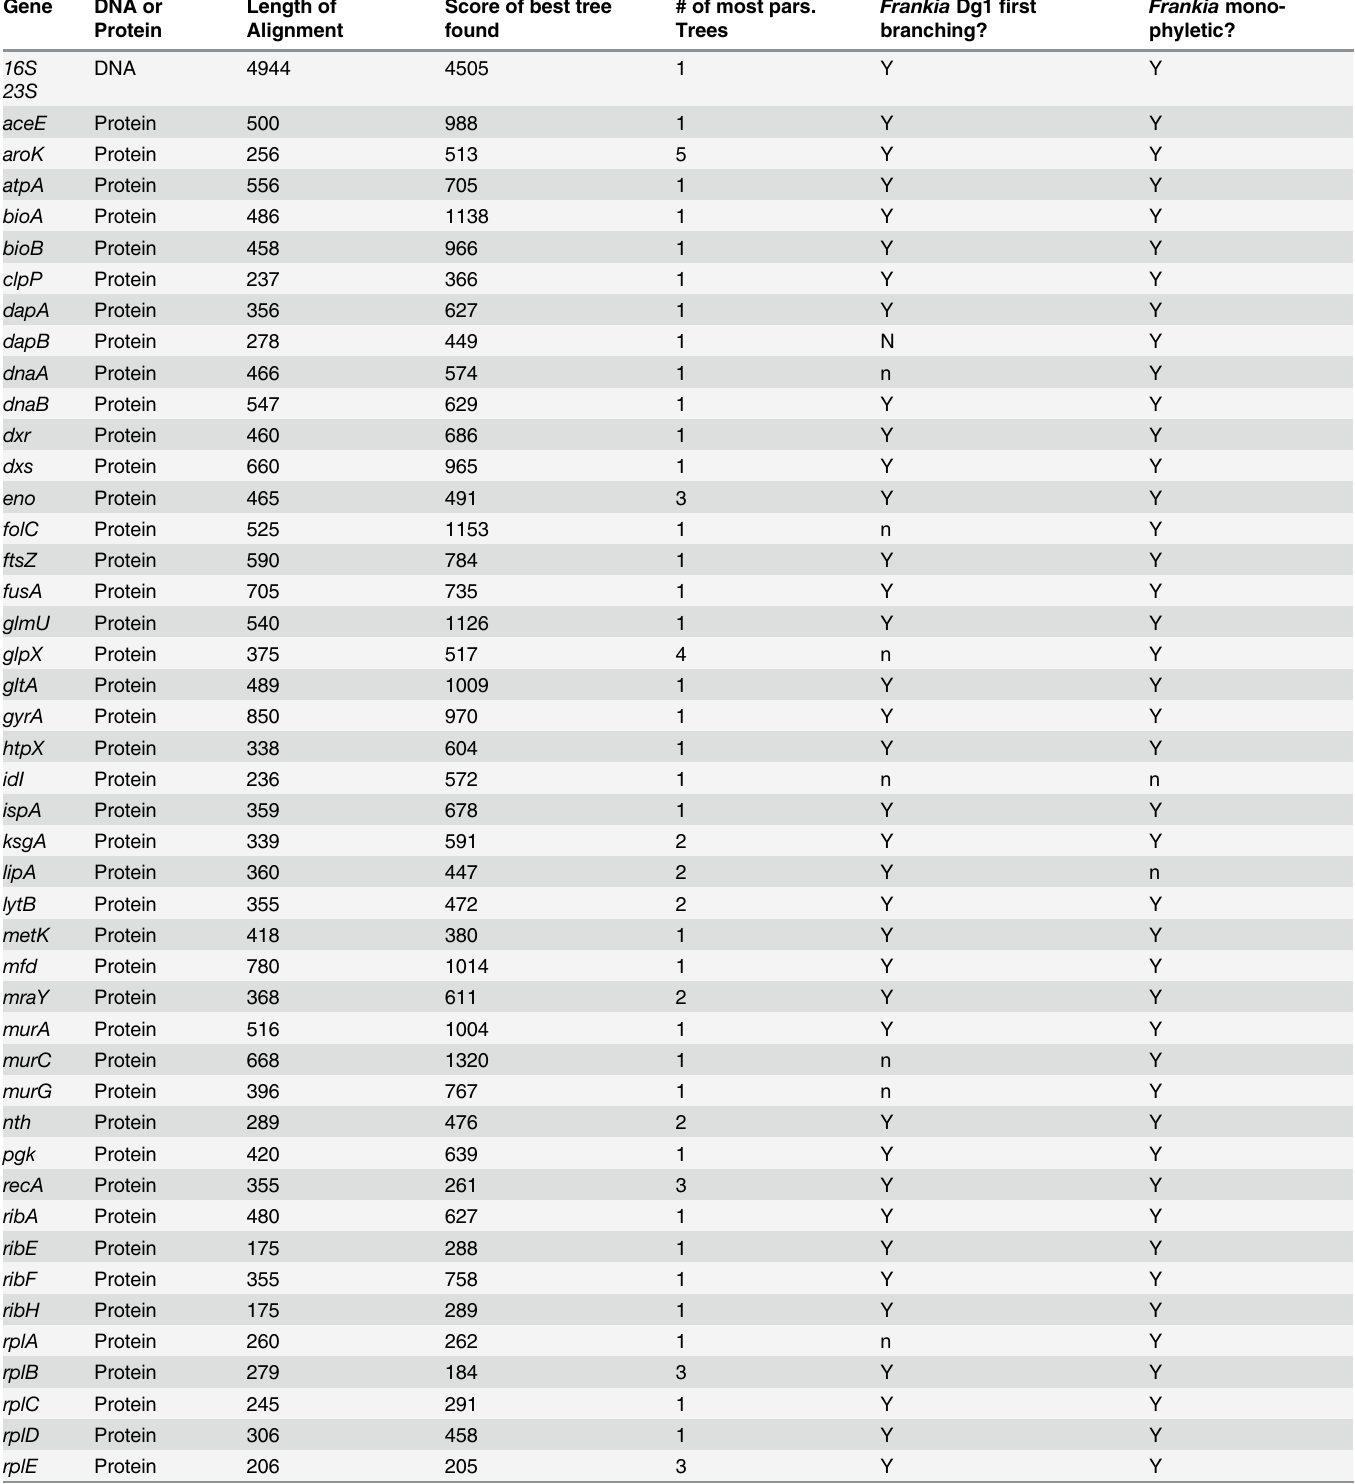
Table 1. Frankia phylogeny was analysed using 50 housekeeping genes and the four published genomes of strains ACN14a and CcI3 (Cluster I), Dg1 (Cluster II) and EAN1pec (Cluster III). Gene DNA or Length of Protein Alignment DNA